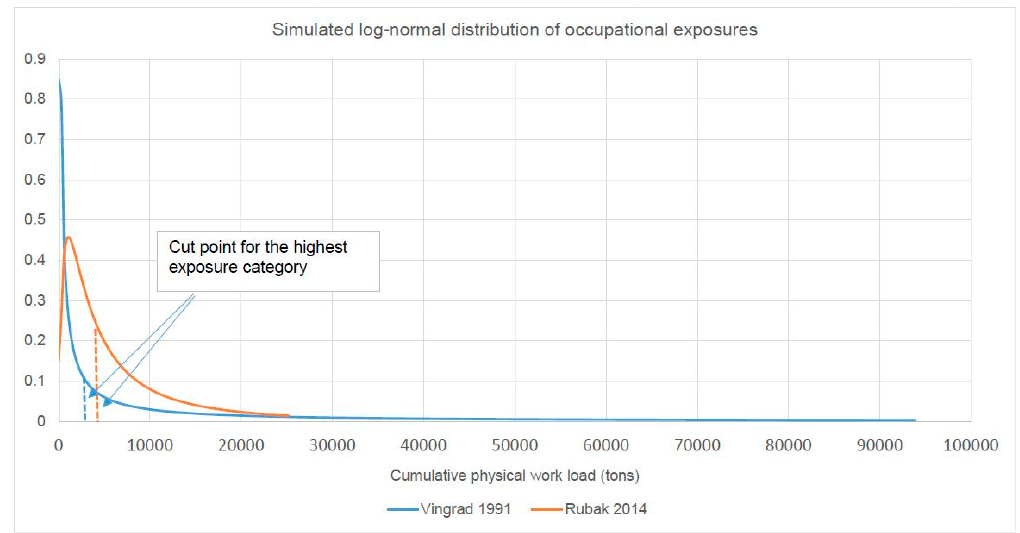
Figure 2. Simulated distributions of occupational workload in the studies by Rubak et al, [18] and Vingard et al. [13] based on published exposure data.